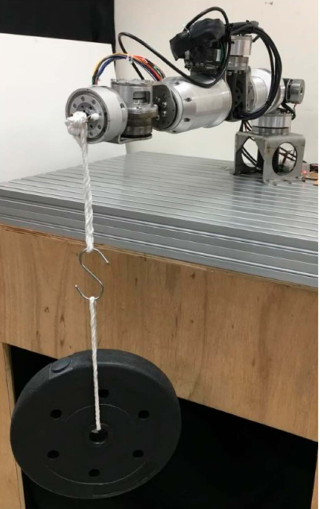
Figure 4. Calibration of Joint 2.